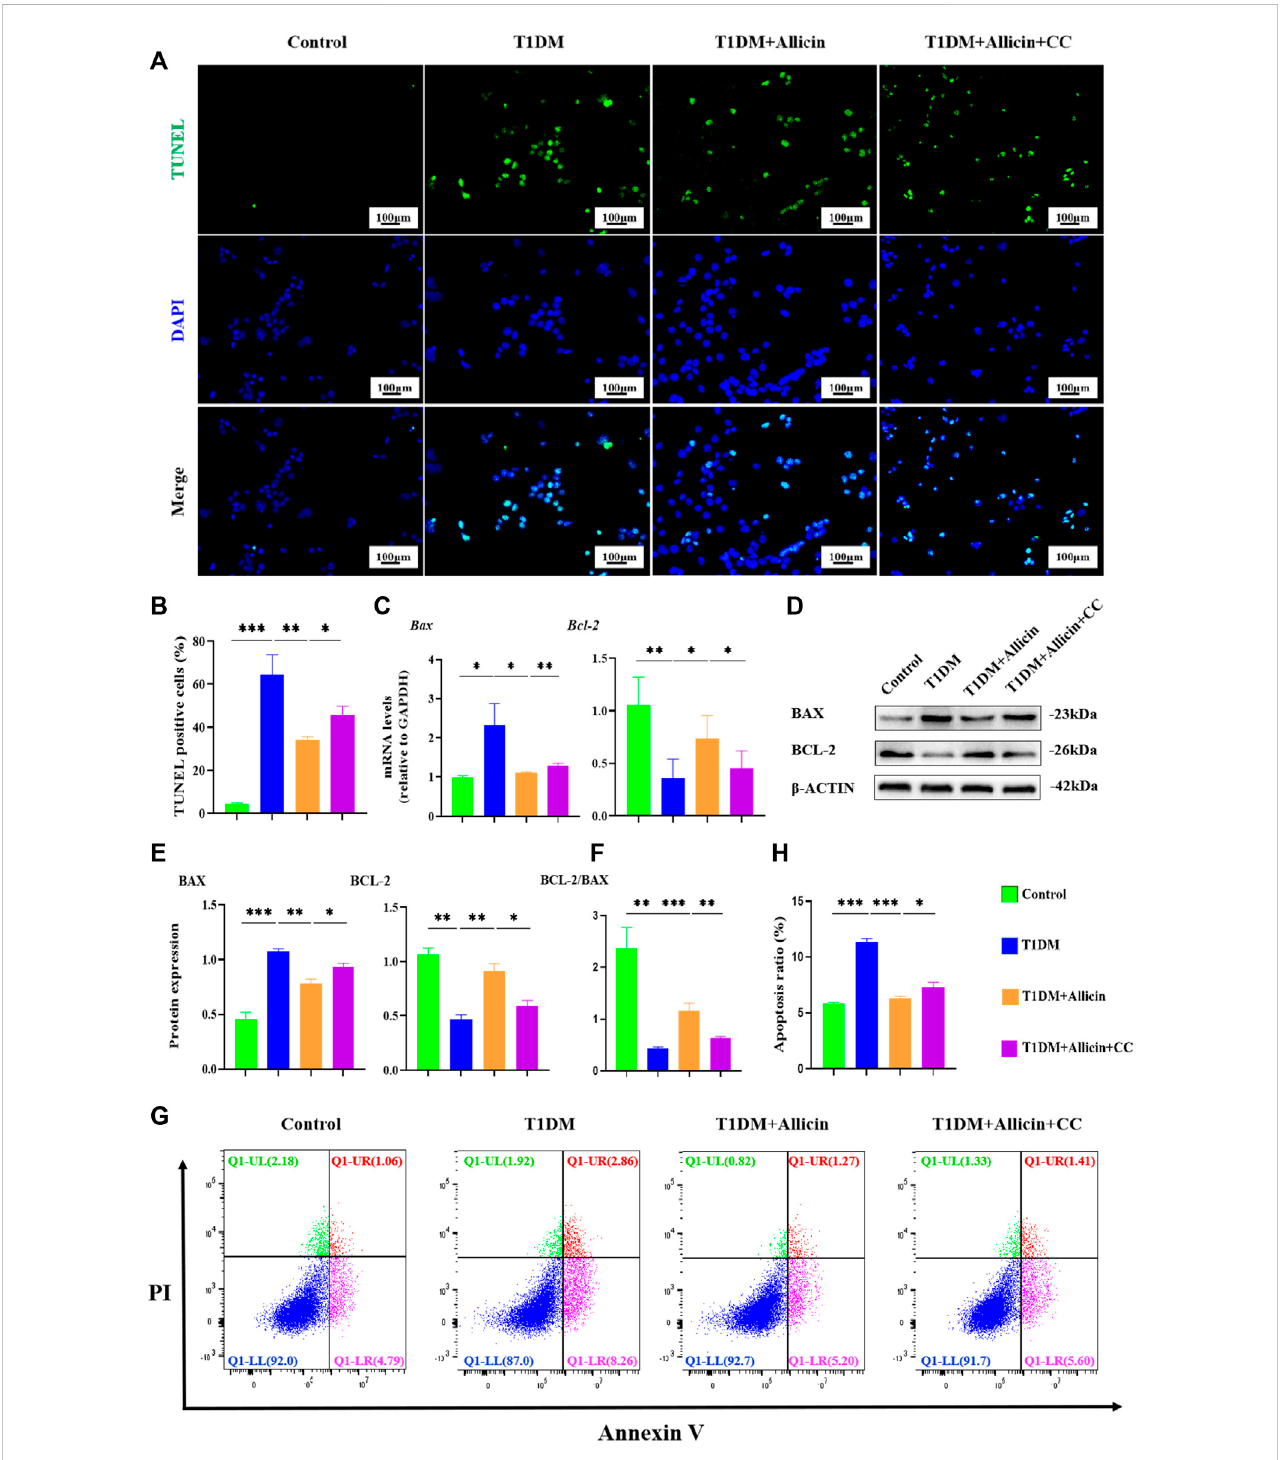
FIGURE 6 Allicin attenuated the apoptosis of STZ-induced pancreatic β cell Min6 in vitro . (A) The detection of pancreatic β cells apoptosis in each group using TUNELstaining.Thecellswithgreen fl uorescencerepresentsapoptosis. (B) Thequanti fi cationofTUNELstaining. (C) ThemRNAlevelof Bax and Bcl-2 ineach groupbyRT-qPCR. (D) Western blotgelimagesofBAXandBCL-2 ineachgroup. (E) Thebargraphsrepresentthequanti fi cationofproteinlevels. (F) Theratio ofBCL-2andBAXproteins. (G) TheexplorationofthecellapoptosisusingAnnexinV-PIapoptosisdetectionkitby fl owcytometry. (H) Thequantitationof fl ow cytometry assay. N = 3, Mean ± SD. *p < .05, **p < .01, ***p < .001 indicate signi fi cant differences. Scale bars 100 μ